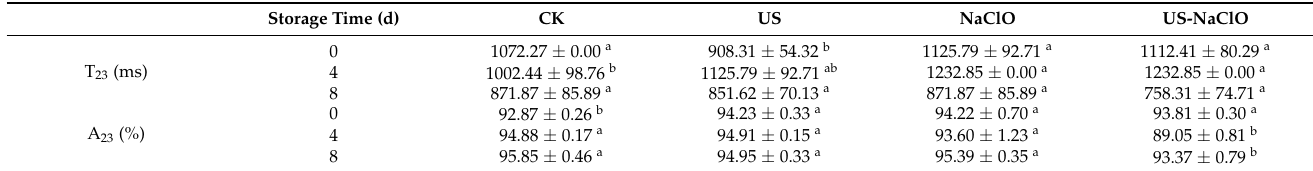
Table 2. Transverse relaxation time (T 23 ) and free water proportion (A 23 ) of fresh-cut cucumber during